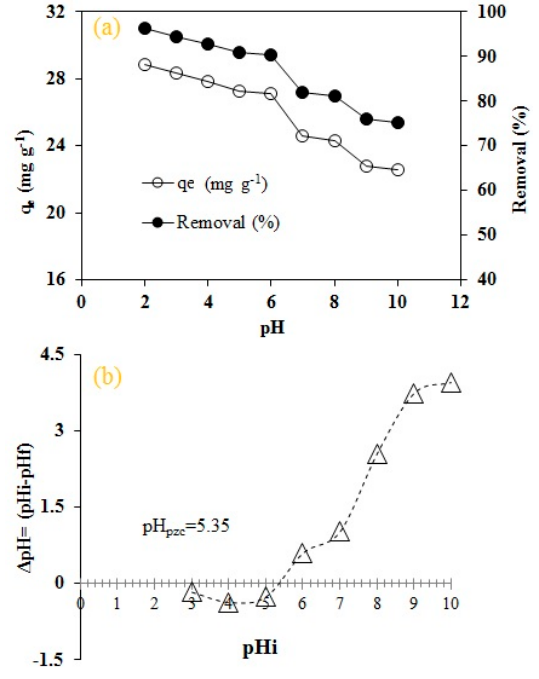
Figure 7. Effect of batch process variables on adsorption of RO16 by MA-AC400: ( a ) pH; ( b ) pH pzc